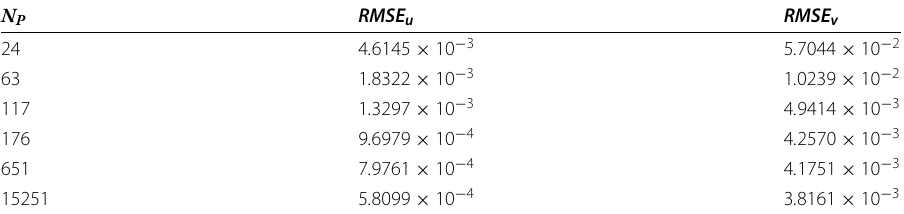
Table 2 The RMSE of Case 2 by increasing N P and fixing N G =